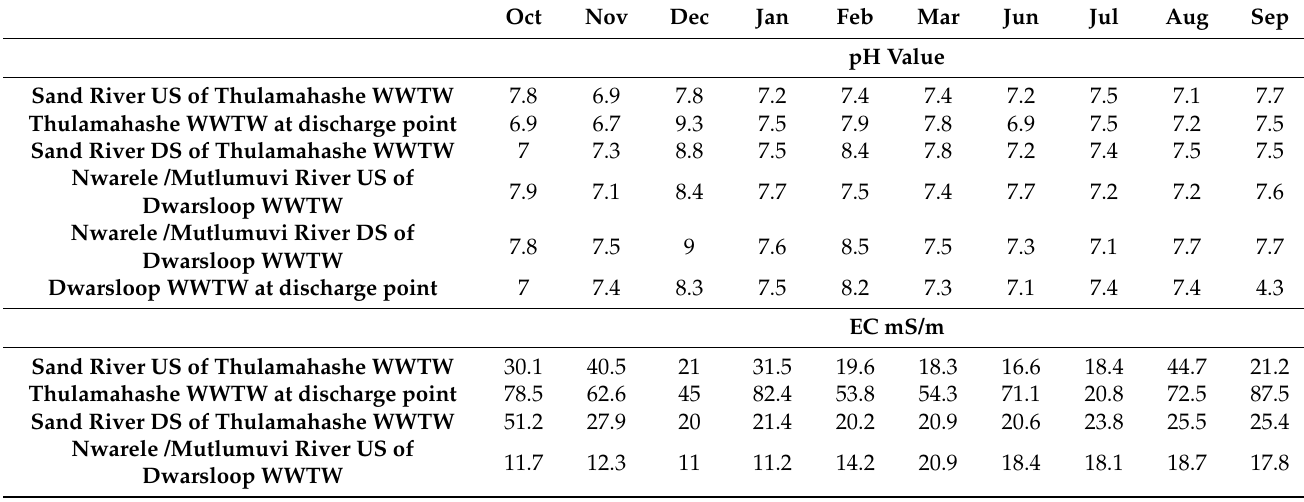
Table 1. Physio-chemical